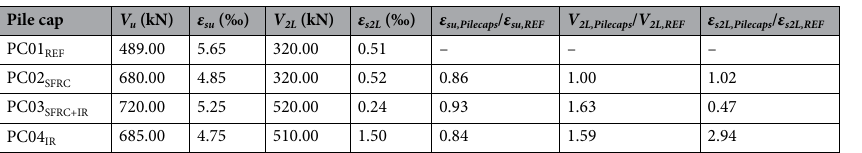
Table 9. Characterization of the V − ε s